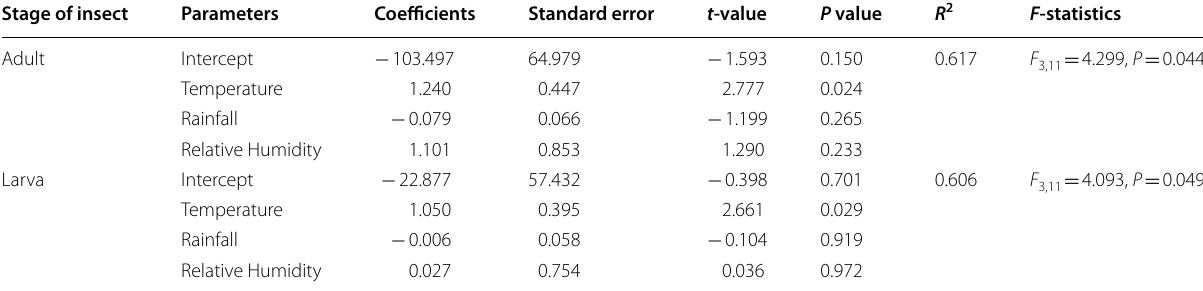
Y insect population/(1 m 2 ) quadrat; X 1 =